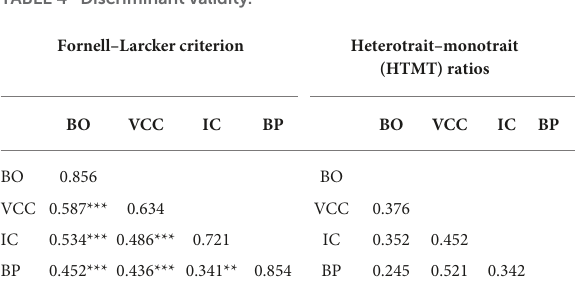
TABLE 4 Discriminant